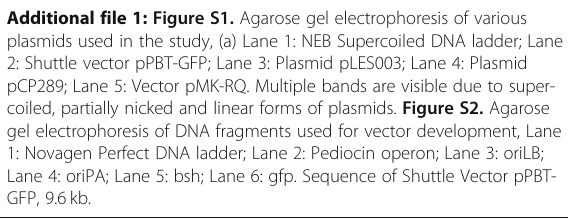
Additional file 1: Figure S1. Agarose gel electrophoresis of various plasmids used in the study, (a) Lane 1: NEB Supercoiled DNA ladder; Lane 2: Shuttle vector pPBT-GFP; Lane 3: Plasmid pLES003; Lane 4: Plasmid pCP289; Lane 5: Vector pMK-RQ. Multiple bands are visible due to super- coiled, partially nicked and linear forms of plasmids. Figure S2. Agarose gel electrophoresis of DNA fragments used for vector development,